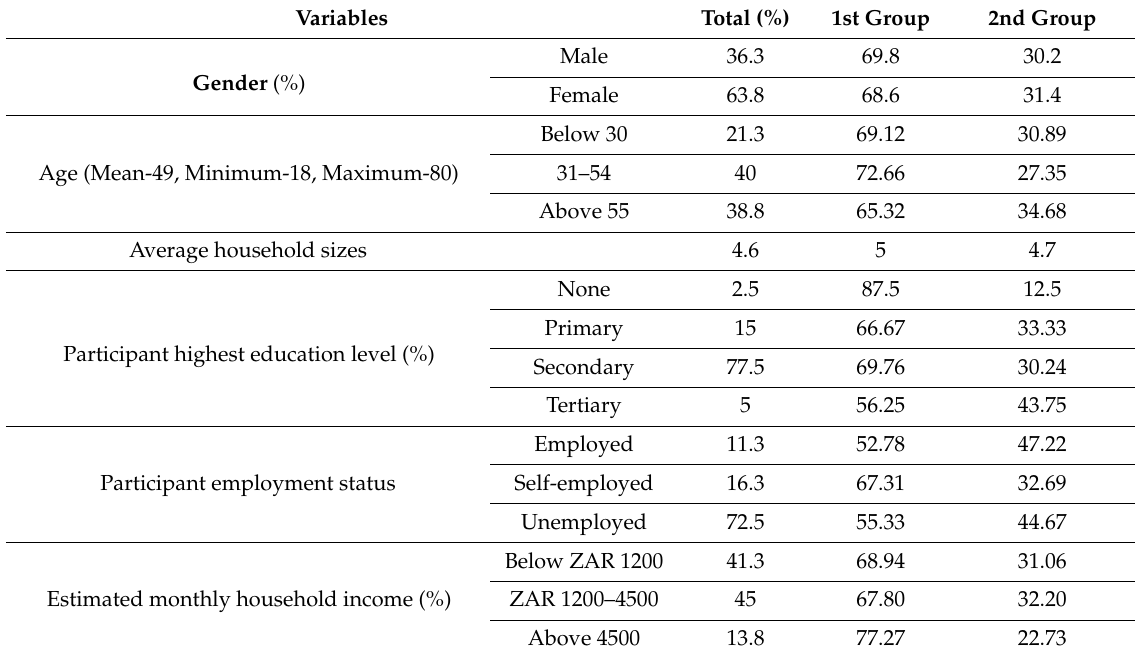
Table 3. Socio-economic characteristics of the households in the